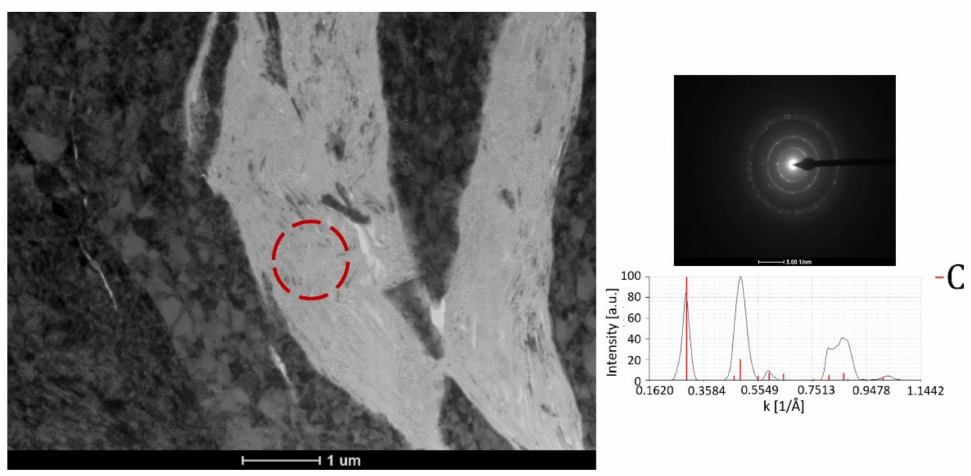
Figure 7. Bright-field TEM image of the graphite with selected area diffraction pattern.